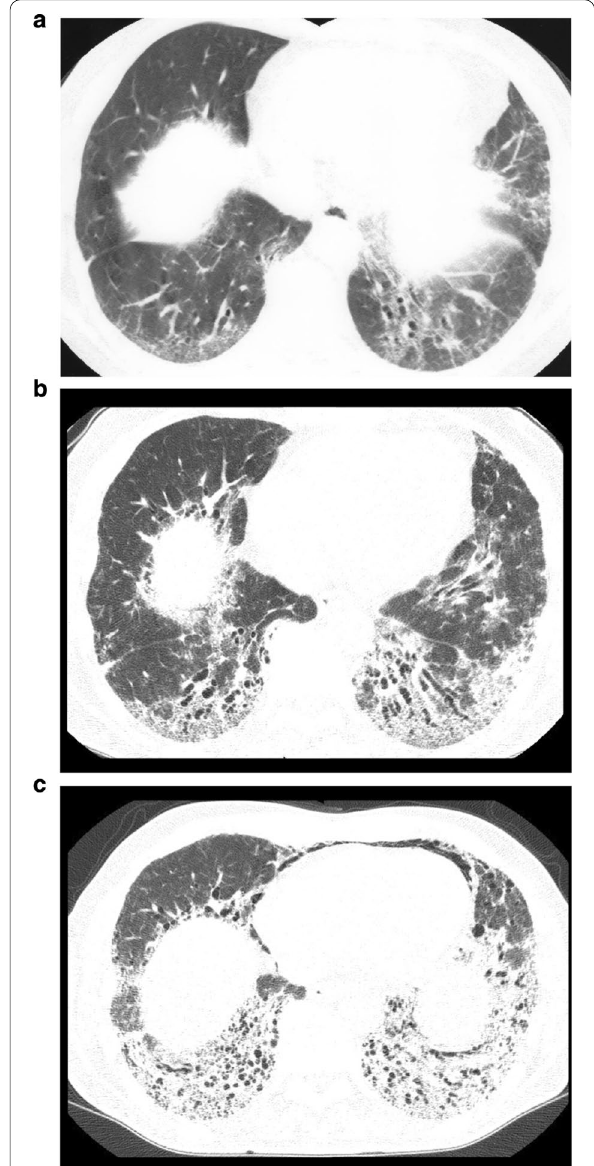
Fig. 6. 59-year-old man with hard metal pneumoconiosis. Initial HRCT scan ( a ) shows scattered areas of ground-glass attenuation associated with fine reticulation and mild traction bronchiectasis. HRCT obtained 3 years later ( b ) reveals increase in parenchymal abnormalities in extent, prominent reticulation, and progression of traction bronchiectasis. HRCT obtained 5 years later ( c ) shows dense increased parenchymal opacities with traction bronchiectasis